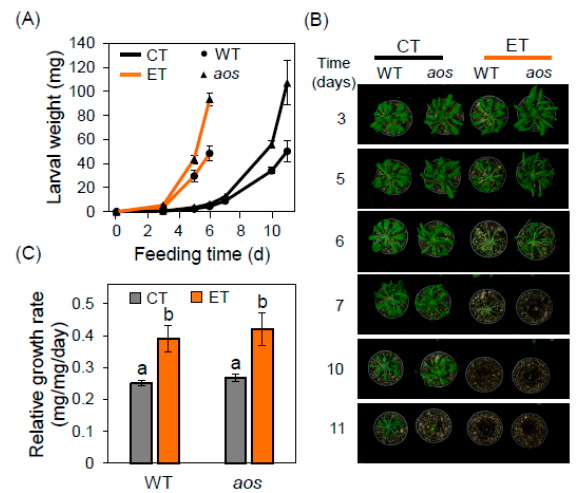
Figure 1. Elevated temperature powerfully stimulates T. ni growth and host plant defoliation. ( A ) Weight of T. ni larvae reared on rosettes of WT (circle) or aos (triangle) plants at the control temperature (CT, 22 °C; black lines) or elevated temperature (ET, 29 °C; orange lines). All plants were grown at CT for 8 weeks and then acclimated to ET or CT conditions for an additional 48 h prior to challenge with two neonate T. ni larvae per plant. Data points denote the mean ± SE of larvae recovered from five plants. ( B ) Representative photographs showing the defoliation of rosettes from plants used for feeding assays shown in panel A. ( C ) Relative growth rate (RGR) of larvae reared on WT or aos plants under CT (gray bars) and ET (orange bars) conditions. RGR was calculated from the data shown in panel A, where the data denotes the mean ± SE of five biological replicates. ANOVA tests indicated that temperature, but not genotype or genotype x temperature interaction, has a significant e ff ect on RGR (P < 0.05). Lowercase letters denote significant di ff erences (Tukey’s honestly significant di ff erence [HSD] test P <